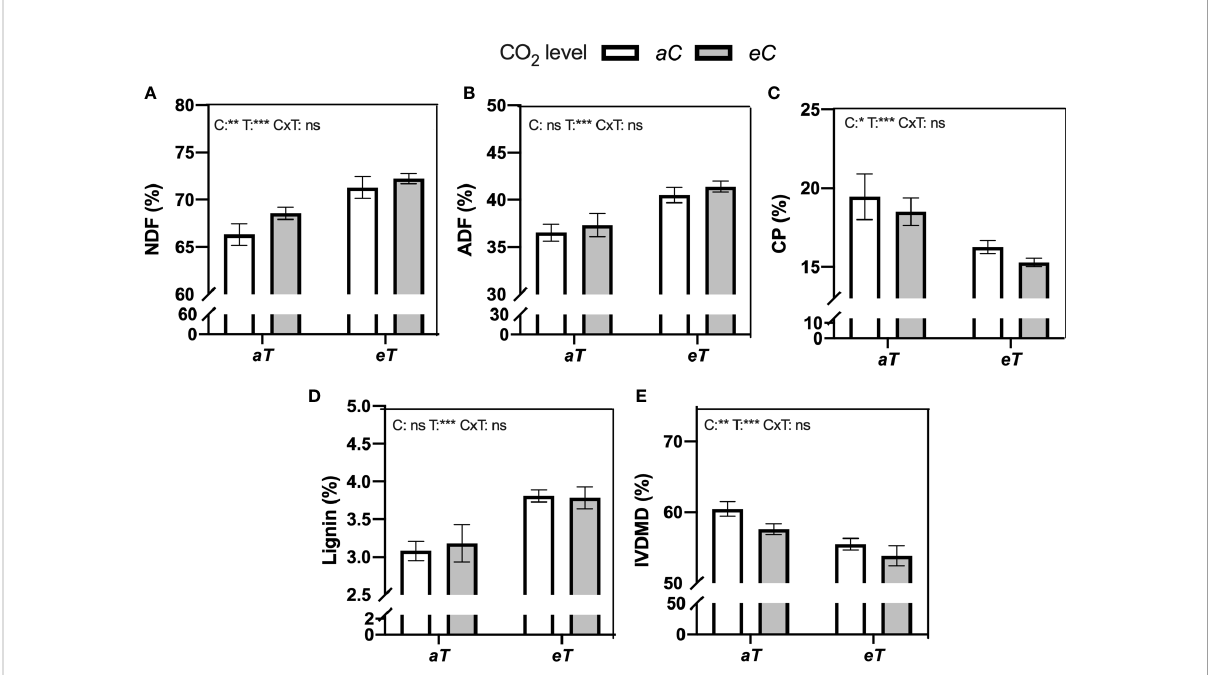
FIGURE 5 Forage nutritional value of the aboveground dry mass of M. maximus measured in different levels of [CO 2 ] and temperature. NDF , neutral detergent fi ber. ADF , acid detergent fi ber. CP , crude protein. IVDMD , in-vitro dry matter digestibility. Treatments: aC (ambient CO 2 concentration), eC (elevated CO 2 concentration – 600 ppm), aT (ambient temperature), and eT (elevated temperature - 2°C above ambient temperature). ANOVA results are shown for each parameter: C, [CO 2 ] effect; T, temperature effect; C×T, interaction between C and T. *P <